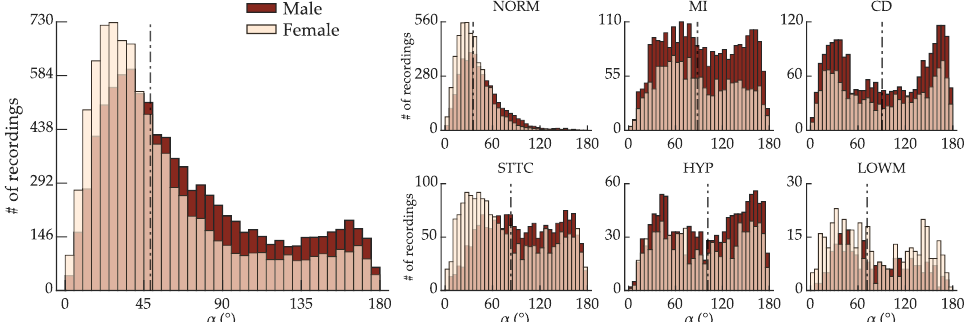
Figure 5. Distribution of spatial QRS-T angles α of across the ranges of α =[0:5:180] ◦ according to sex (overlapped) for all eligible recordings in the dataset ( left ) and for each morphological class ( right ). α #» #» u QRS and u T . The dashed line is the median α for each is the angle between the VCG vectors